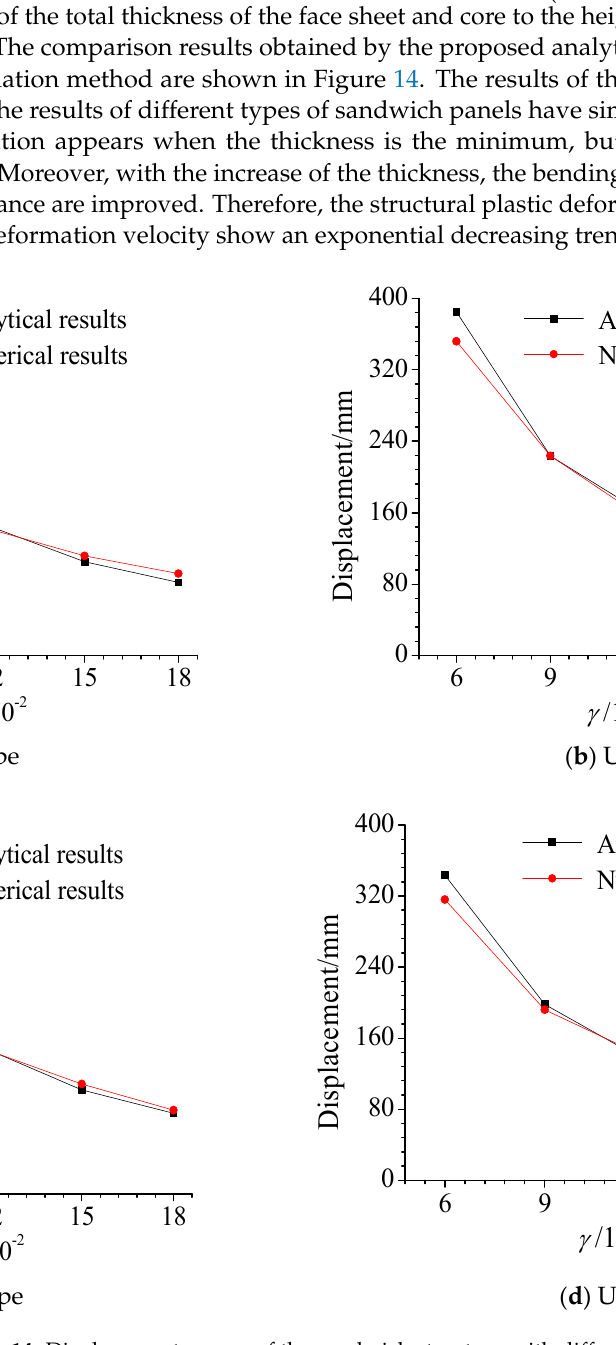
Figure 14. Displacement curves of the sandwich structure with different thicknesses ( γ is the ratio of the total thickness of the face sheet and the core to the height of the sandwich panel).